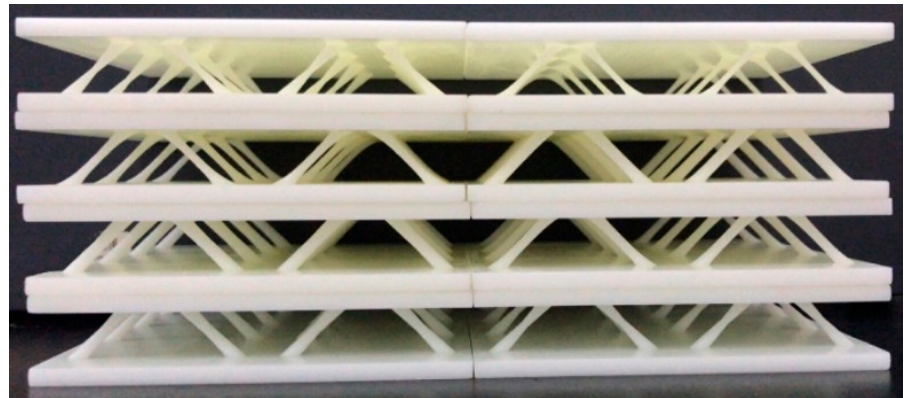
Figure 4. Manufactured 2-D lattice structures with variable cross-section cores.